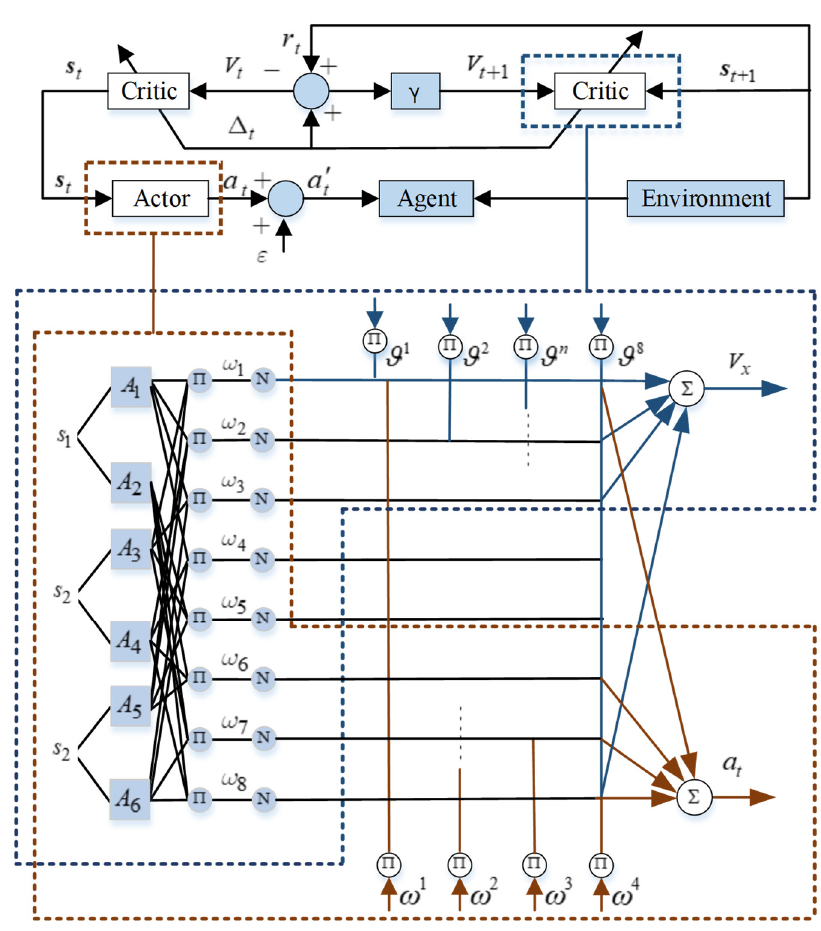
Figure 2. The architecture of the fuzzy actor–critic learning algorithm.